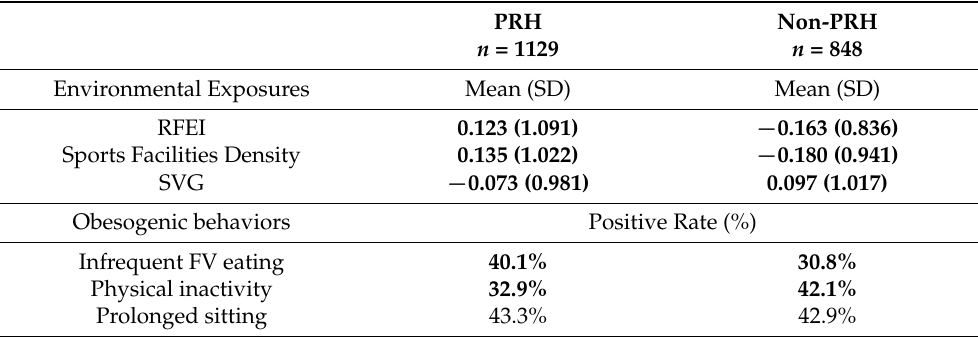
Table 2. Descriptive statistics of environmental exposures and obesogenic behaviors among adults with PRH and non-PRH residence.